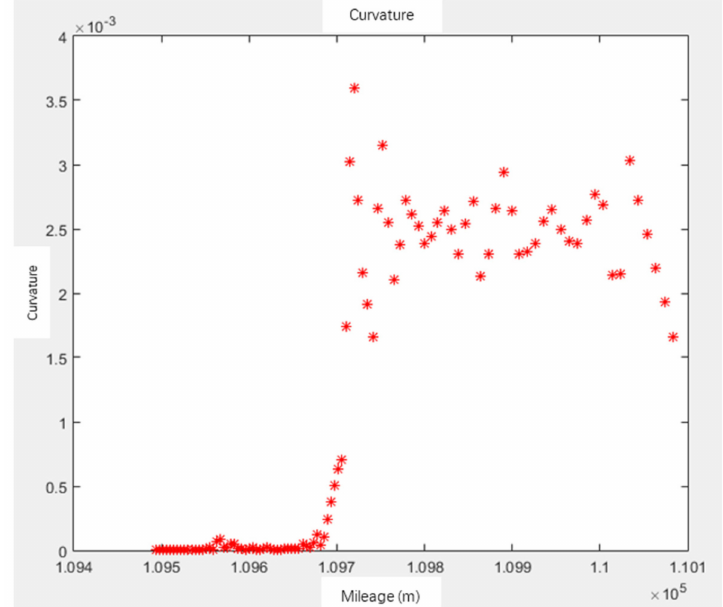
Figure 5. Curvature calculation.